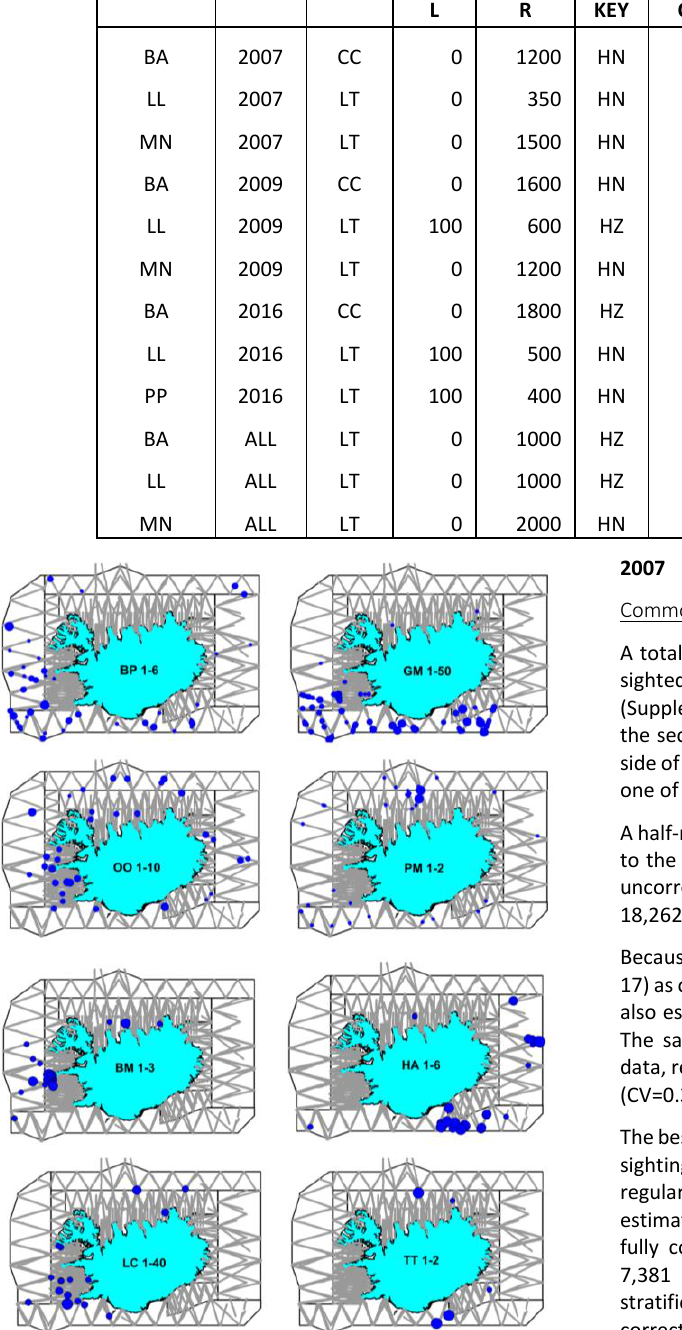
Figure 8. Realized survey effort from all surveys and sightings of cetaceans by species. Symbol size varies with group size in the number range given. BP – fin whale; GM – long-finned pilot whale; OO – killer whale; PM – sperm whale; BM – blue whale; HA – northern bottlenose whale; LC – white-sided dolphin; TT – common bottlenose dolphin.